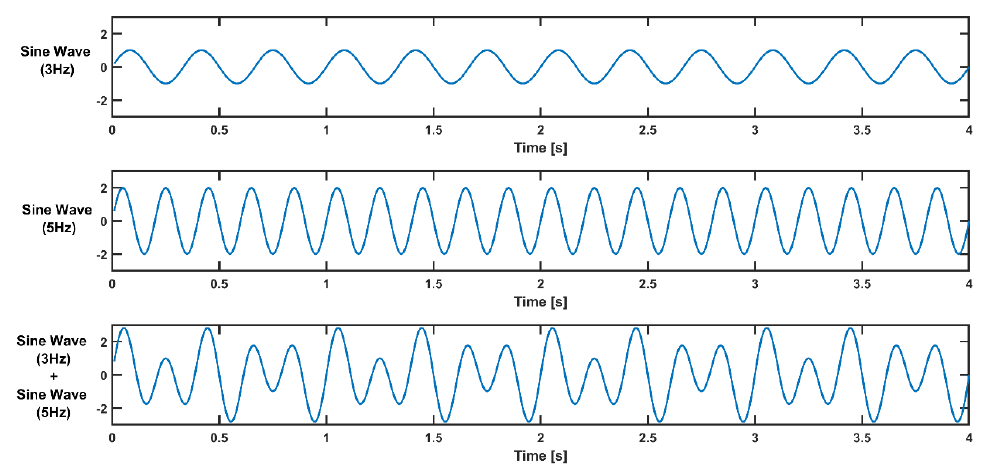
Figure 6. Simulated signal with two frequencies (3 Hz and 5 Hz) generated from a sine wave at 3 Hz and a sine wave at 5 Hz.